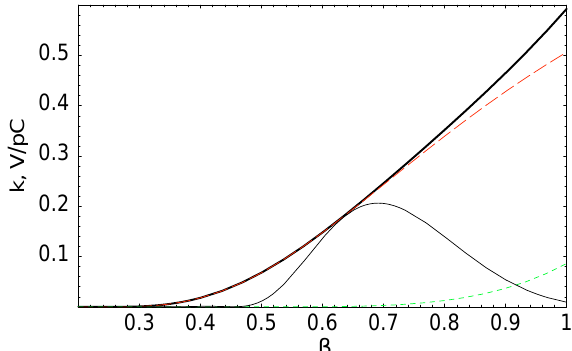
FIG. 7. (Color). The total loss factor for all modes below the cutoff in the 5-cell APT b (cid:173) (cid:48)(cid:46)(cid:54)(cid:52) versus b . The contribution of the TM (cid:48)(cid:49)(cid:48) band is plotted by the long-dashed line, and that of the TM (cid:48)(cid:50)(cid:48) band is plotted by the short-dashed line. The thin solid line shows the loss factor for the accelerating mode, TM (cid:48)(cid:49)(cid:48) p mode.